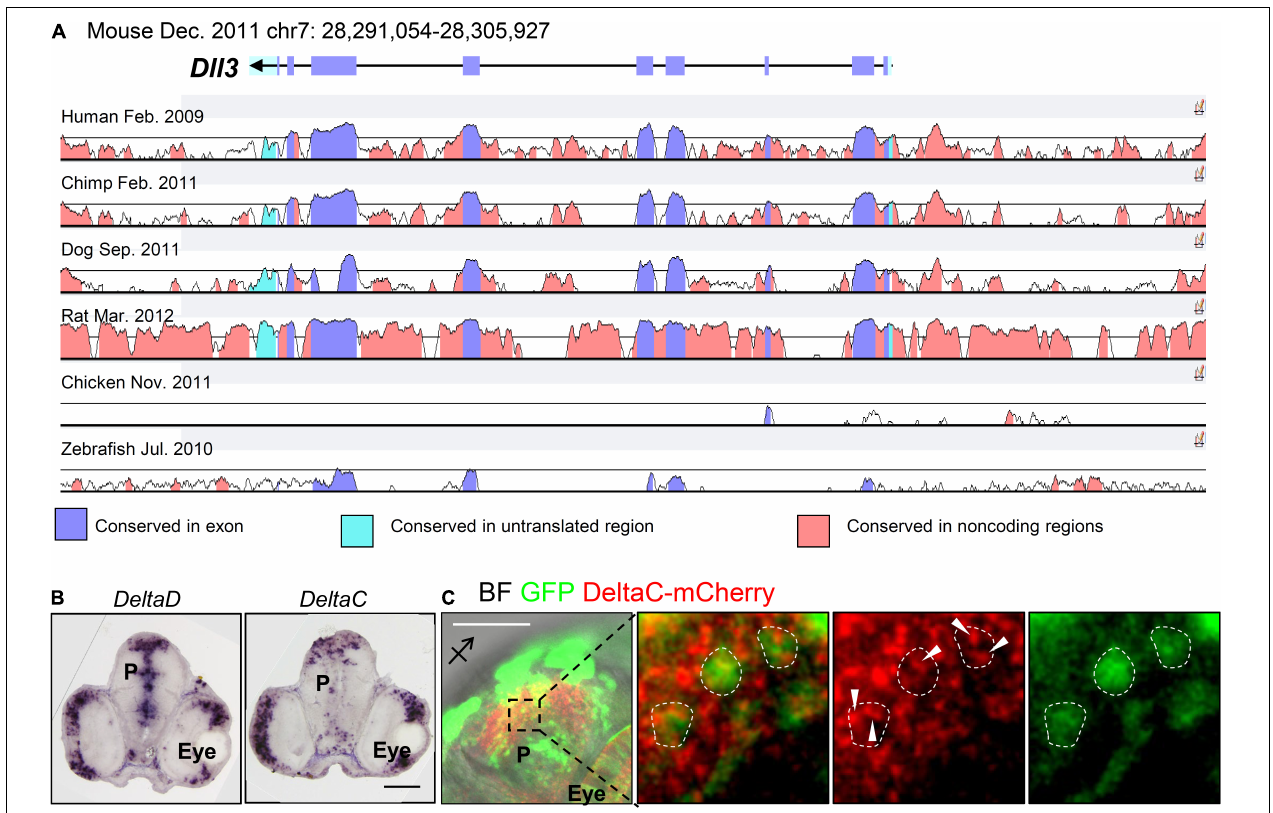
FIGURE 2 | Conservation of Dll3 among species. (A) VISTA Browser display of a 14.9 kb fragment of the Dll3 region on Chr. 7 of the mouse genome (chr7: 28,291,054–28,305,927). VISTA plots are shown in the seven-way (Mouse-Human-Chimp-Dog-Rat-Chicken-Zebrafish) alignment. Based on the annotation, conserved regions above 50%/100 bp in VISTA are above the cutoff, and are colored under the curve with the indicated color. (B) Spatial expression of DeltaD and DeltaC in the 2 dpf zebrafish brain slice. (C) The expression pattern of DeltaC–mCherry in the zebrafish brain 2 days after introducing the plasmids carrying DeltaC–mCherry or GFP at 4-cell stage. BF: bright field. White dotted lines circle GFP-positive cells and arrows indicate puncta pattern of DeltaC-mCherry. Scale bar: 100 µ m.